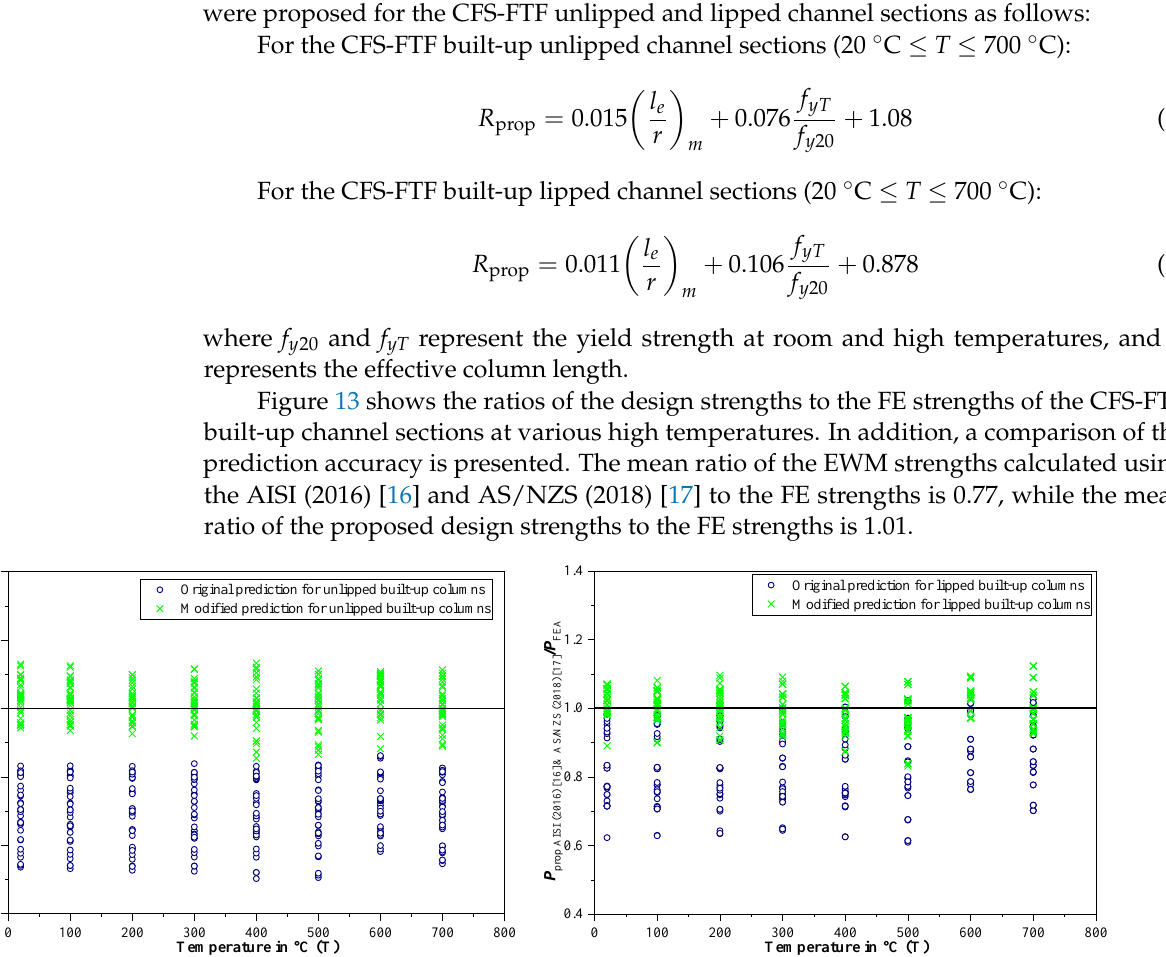
Table 3. Reliability analysis results.